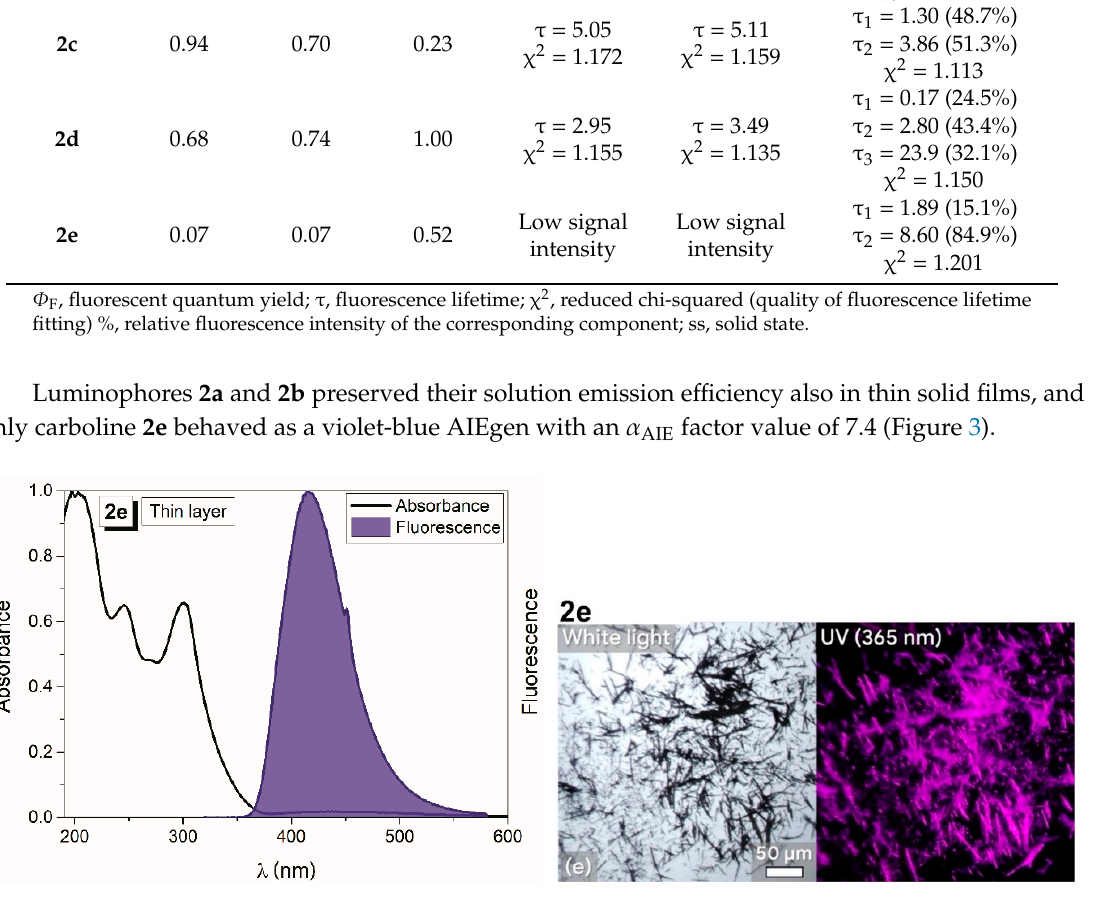
Figure 3. Absorption and emission spectrum of 2e in the thin solid film layer on the quartz substrate ( λ EXC = λ A ) ( left ) and the micrograph of synthesized carboline 2e under visible (white) light and UV light (365 nm). The micrograph illustrates the crystals and fluorescence of 2e in thin solid film ( right ). Carboline 2c exhibited the aggregation-caused quenching (ACQ) phenomenon, and its fluorescent quantum yield significantly decreased from approximately 0.8 in solution to the value of 0.2 in the thin solid film (Table 3). As expected, luminophore 2d with a rigid phenylethynyl spacer absorbed light in the violet region of the electromagnetic spectrum due to increased conjugation of anthracene with the phenylethynyl linker and exhibited really strong emission in the solid state with almost 100% efficiency ( Φ F ~ 1; Table 3). Interestingly, when irradiated with visible (Vis) light of a 405-nm wavelength, luminophore 2d in thin solid film underwent a photochemically-allowed [4 π s + 4 π s ] dimerization through anthracene subunits, with the typical decrease of the long-wavelength absorption band in the Vis region and the appearance of a new strong light anthracene dimer absorption around 250 nm (Figure 4) [29]; contrary to the Diels–Alder dimer of 9- phenylethynylanthracene with the typical vibrational structure of the anthracene absorption band between 350 and 400 nm [30]. This Vis light-driven dimerization phenomenon in the solid state and its back thermally-driven reaction could be important for reversible optical writing and data storage applications [31–33]; however, the switching system needs deeper investigation, which is out of the scope of this paper. Bi- and tri-exponential fluorescence decay behavior in the solid films versus mono-exponential fluorescence decay in both polar and non-polar solutions, together with evident bathochromic shift of the emission maximum, clearly indicated aggregation of the carbolines 2a – 2e in the solid state (Table 3, Figure 5).